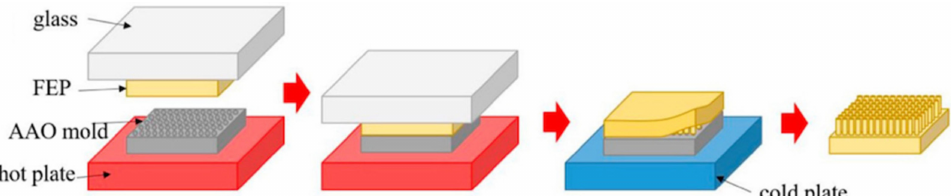
Figure 23. Schematic illustration of hot embossing technique [140]. A fluorinated ethylene propylene (FEP) sheet is pressed on a heated anodic aluminum oxide (AAO)